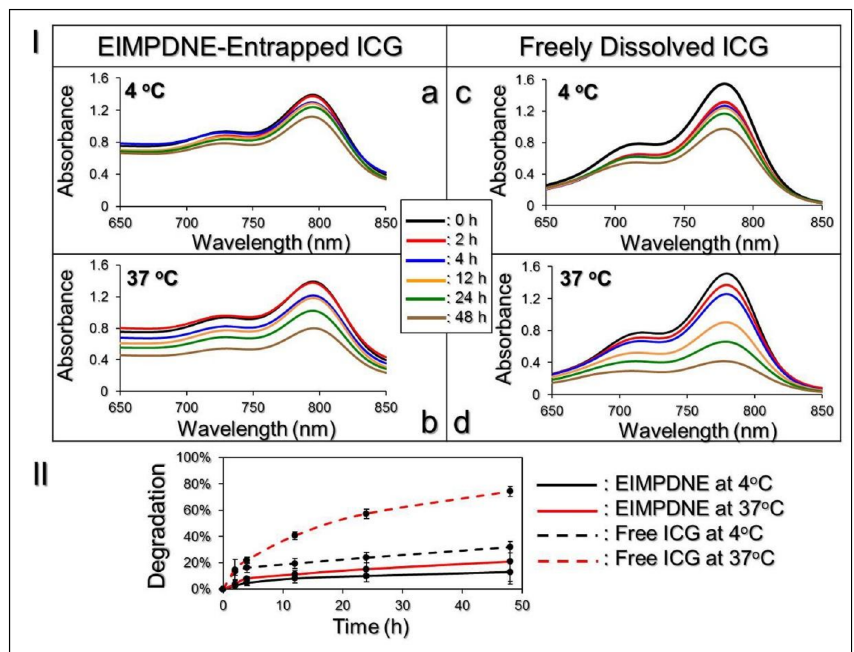
Figure 3. Evaluation of thermal stability of the EIMPDNE-entrapped ICG in comparison with freely dissolved ICG in deionized (DI) water. ( I ) a – d show the UV-Vis spectra of EIMPDNE-entrapped ICG ( a , b ) and free indocyanine green (ICG) ( c , d ) in DI water under 4 ( a , c ) or 37 ◦ C ( b , d ) incubation in the dark for 0, 2, 4, 12, 24, and 48 h. The absorbance value detected at λ = 780 nm in each spectrum curve represents the level of intact ICG remaining in the sample at the time of measurement. ( II ) Degradation curves of the EIMPDNE-entrapped ICG and freely dissolved ICG in DI water that was maintained at 4 or 37 ◦ C for 48 h. Values are mean ± s.d. ( n = 3).